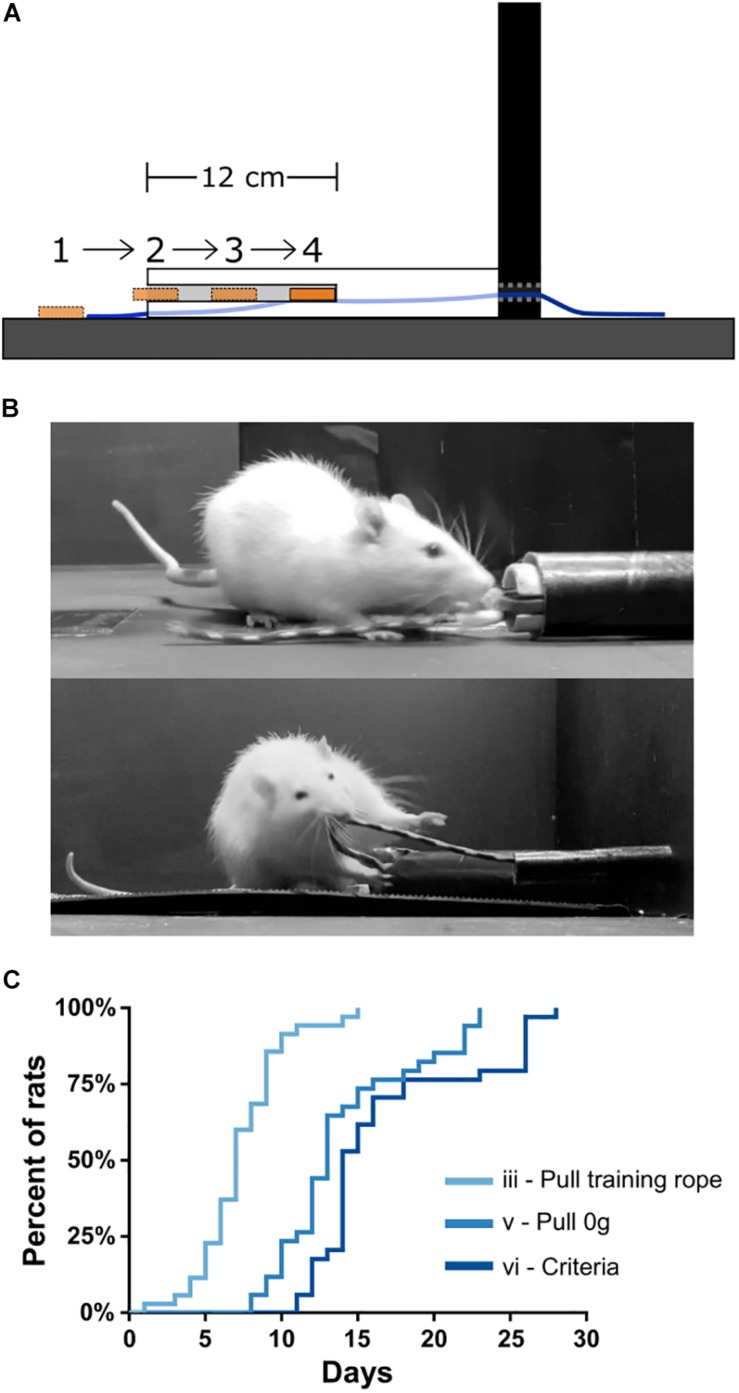
WLT training. (A) Schematic showing profile of training tube and the progressive placement of the sucrose dish further and further inside the training tube. (B) Picture of a rat learning to pull the training dish (stage ii; top) and pulling the 0 g weighted rope (stage v; bottom). (C) Training data for 35 rats indicating mastery of stages iii, v, and vi.